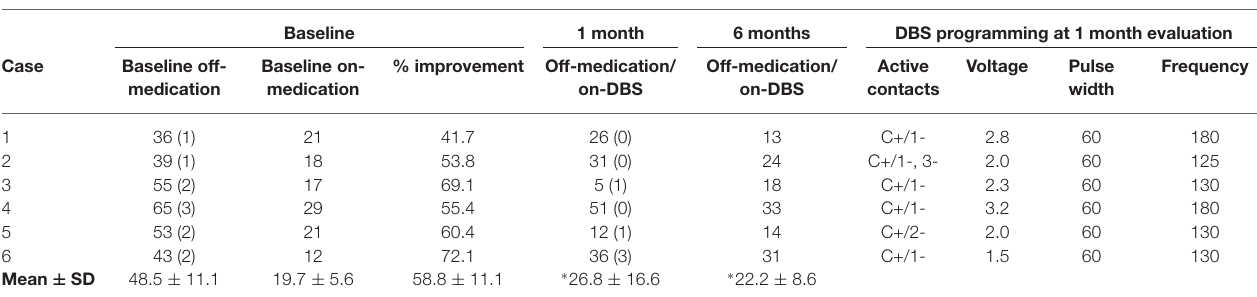
TABLE 2 | Clinical outcomes. Baseline 1 month 6